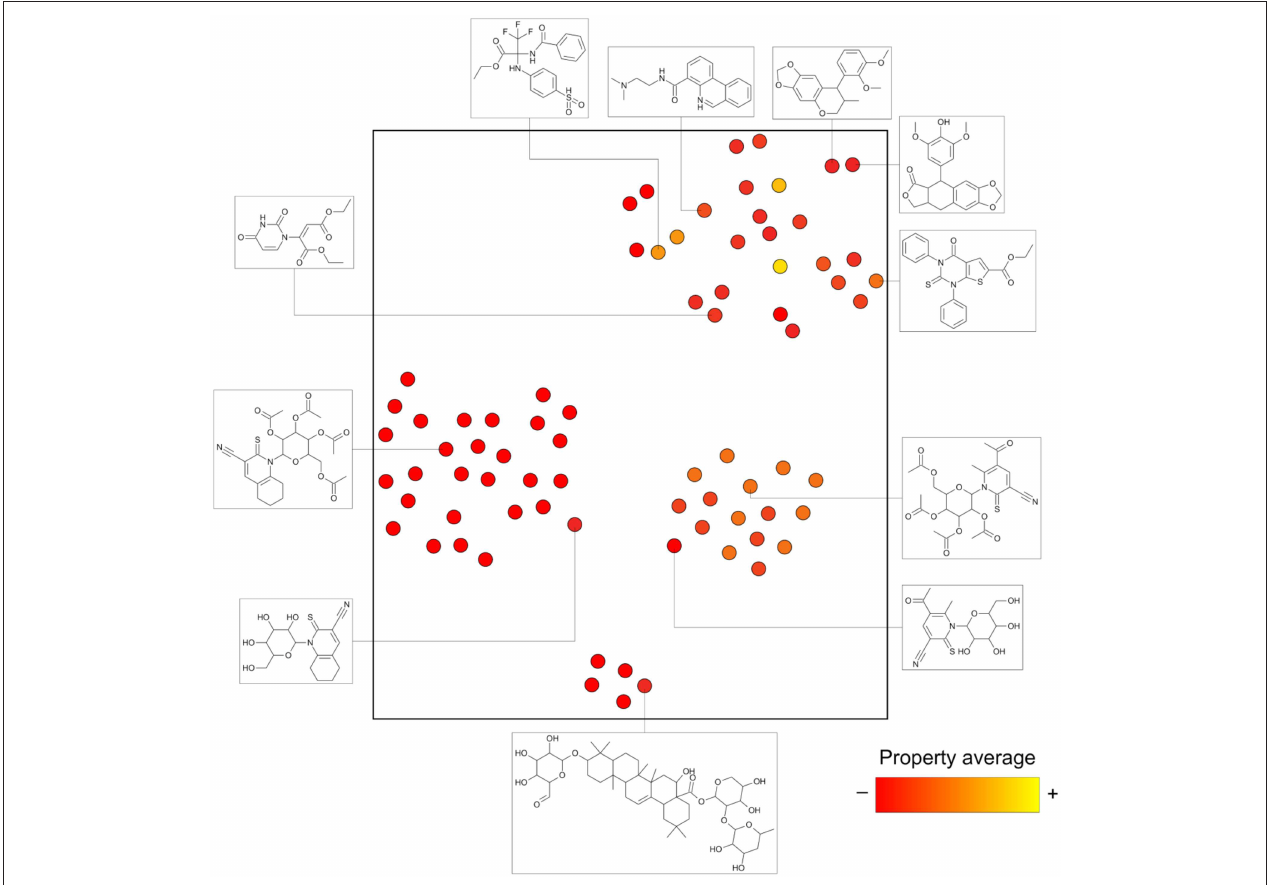
FIGURE 1 | A hypothetical example of a typical chemical space representation based on coordinates. The axes represent the chemical space and have abstract meanings regarding a combination of descriptors. In this case, t -SNE using Morgan fingerprints was applied. Every dot represents a single molecule. In activity landscape modeling, color is used to indicate a property (potency in a particular biological